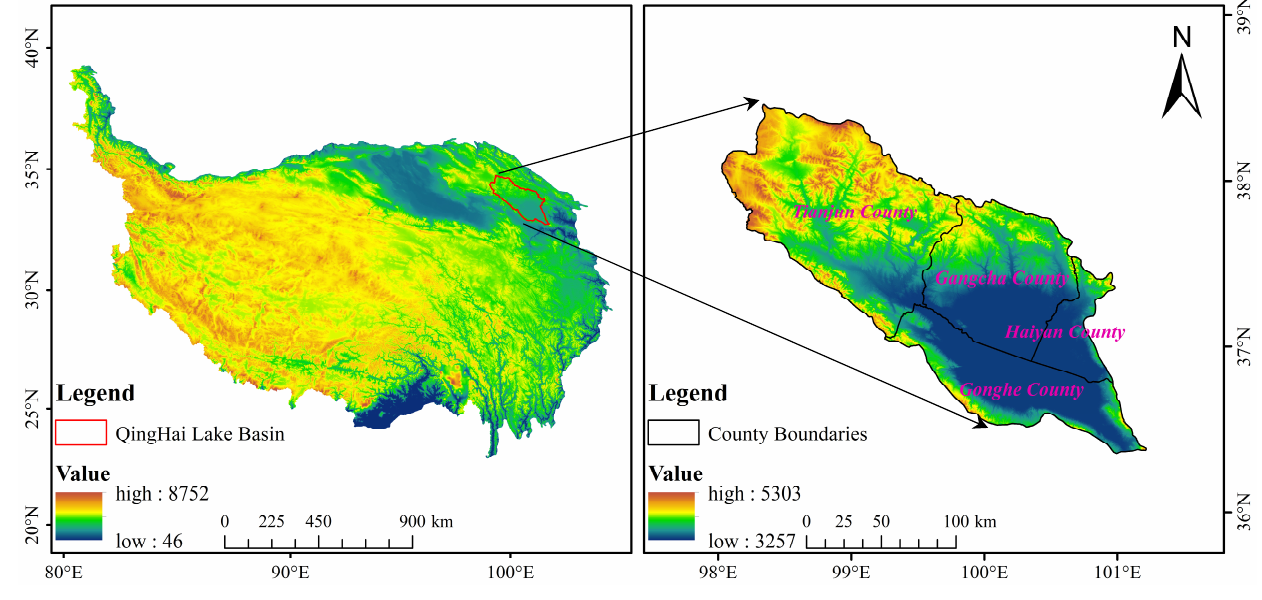
Figure 1. Study area.